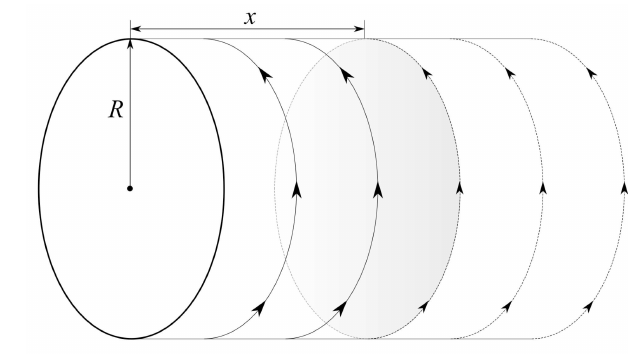
Figure 2. Sketch of cylindrical wake with radius R and a step change in vortex strength at a distance x from the rotor.